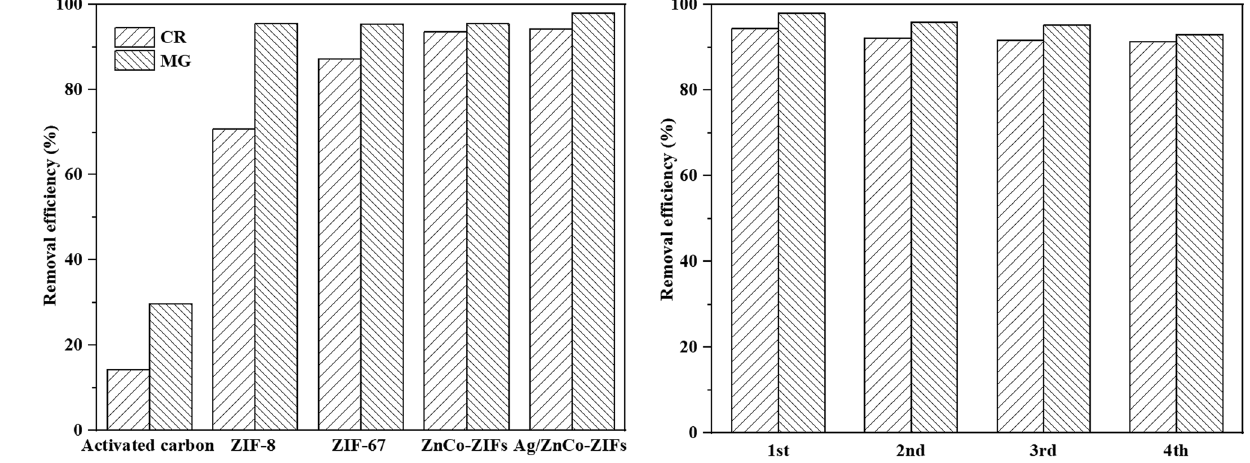
Figure 7: Comparison of CR and MG removal e ffi ciency among heterogeneous catalysts and Ag/ZnCo - ZIFs. CR: pH 7.1, catalyst dosage = 150 mg L − 1 , [ H 2 O 2 ] = 0.05 mol L − 1 , initial [ CR ] = 30 mg L − 1 , temperature = 30°C, time = 45 min. MG: pH 6.0, catalyst dosage = 100 mg L − 1 , [ H 2 O 2 ] = 0.05 mol L − 1 , initial [ MG ] = 30 mg L − 1 , temperature = 30°C, time = 30 min.